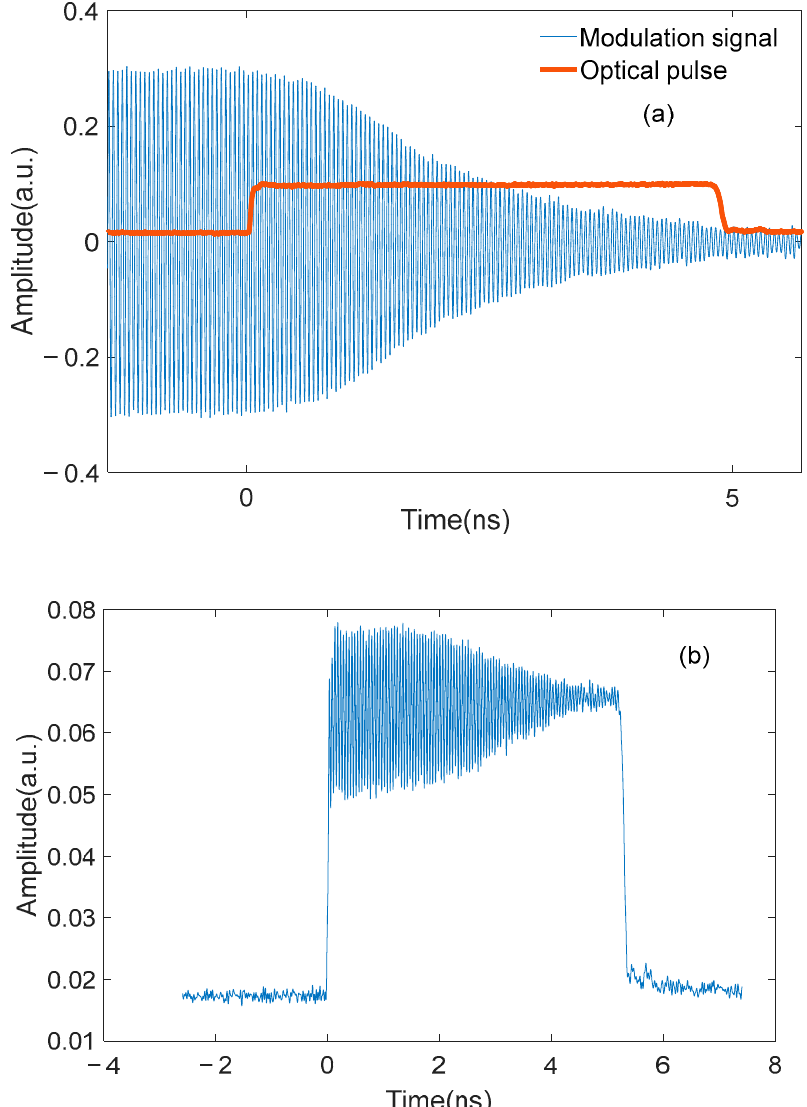
Figure 6. Experimental results of the specific phase modulation. ( a ) Synchronous display between optical pulse and modulation function. ( b ) Time domain curve after phase modulation and 100 m fiber length.